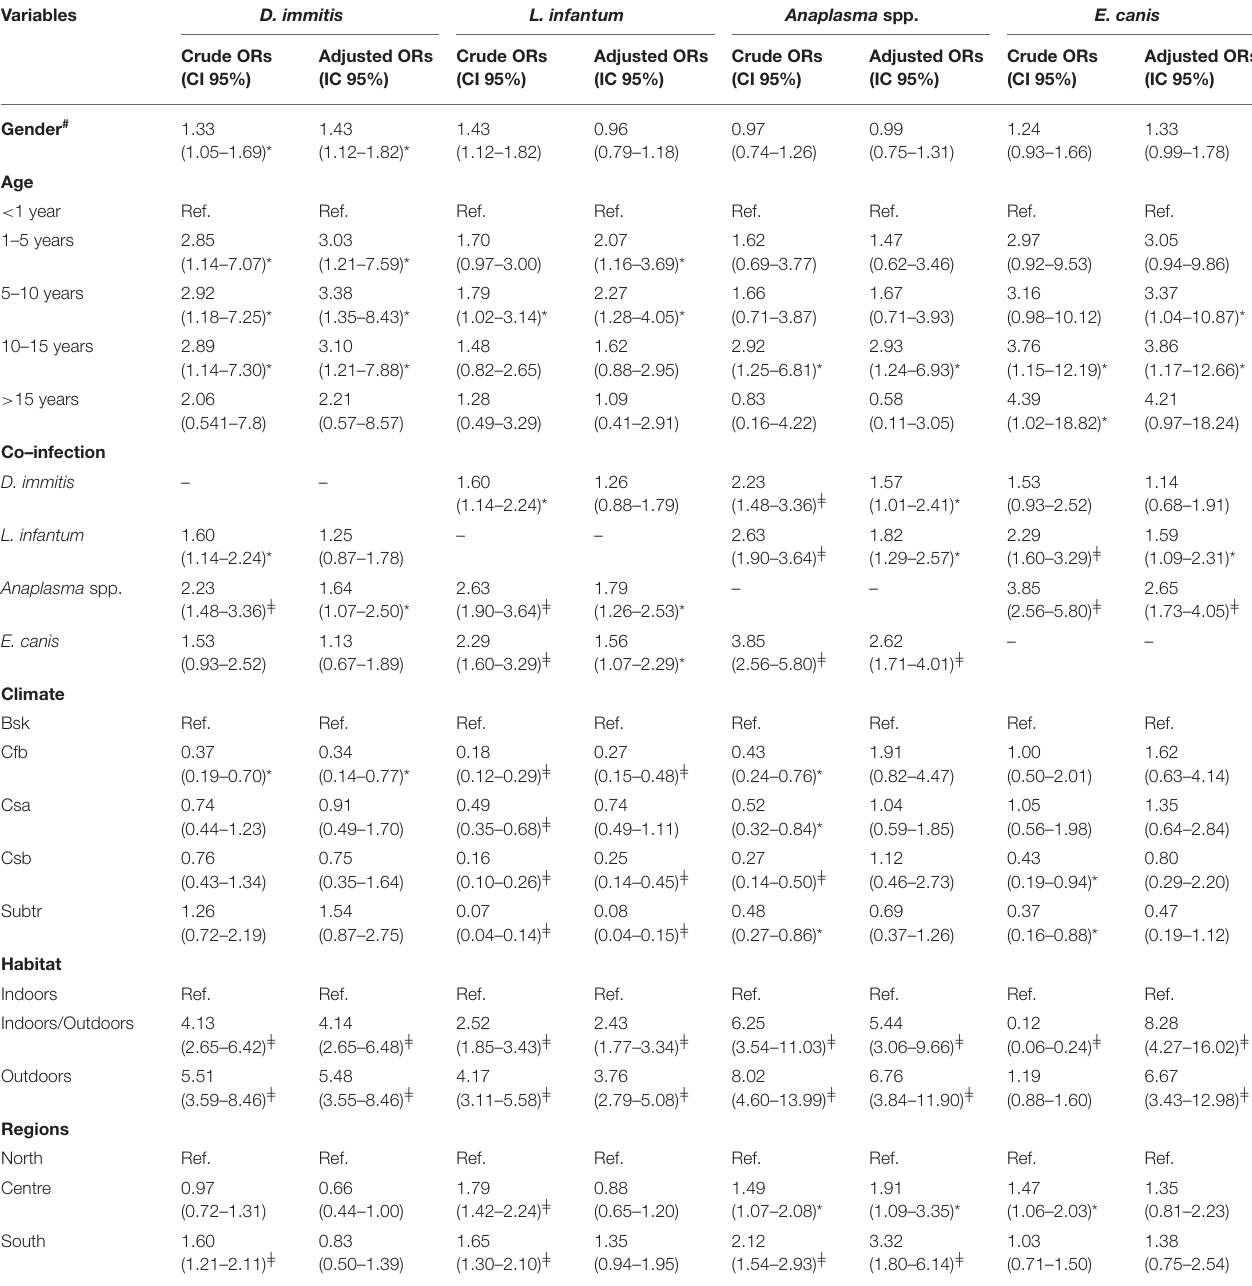
TABLE 3 | Factors associated with the presence of D. immitis, L. infantum, Anaplasma spp., and E. canis .